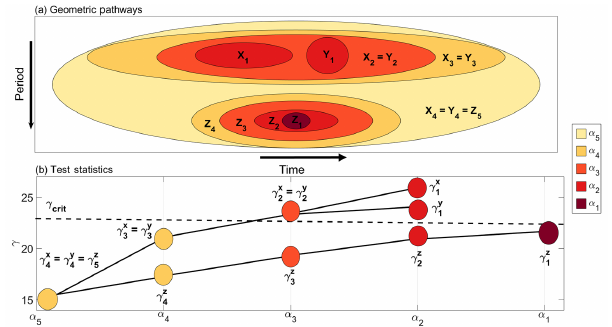
Figure 9. (a) Geometric pathway of three significance patches, X , Y , and Z in the interval I = (cid:2) α 1 ,α 5 (cid:3) . (b) The cumulative areas of geometric pathway elements, where the summation begins at α 5 , and the dotted line represents the critical level of the cumulative areawise